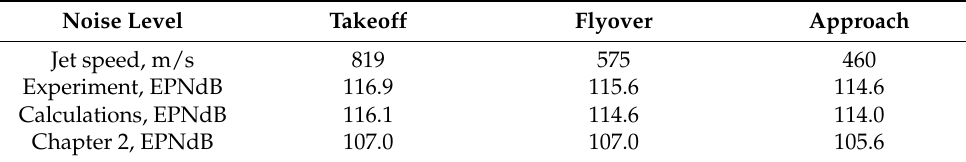
Table 2. Calculations of noise levels for Tupolev-144 at the certification